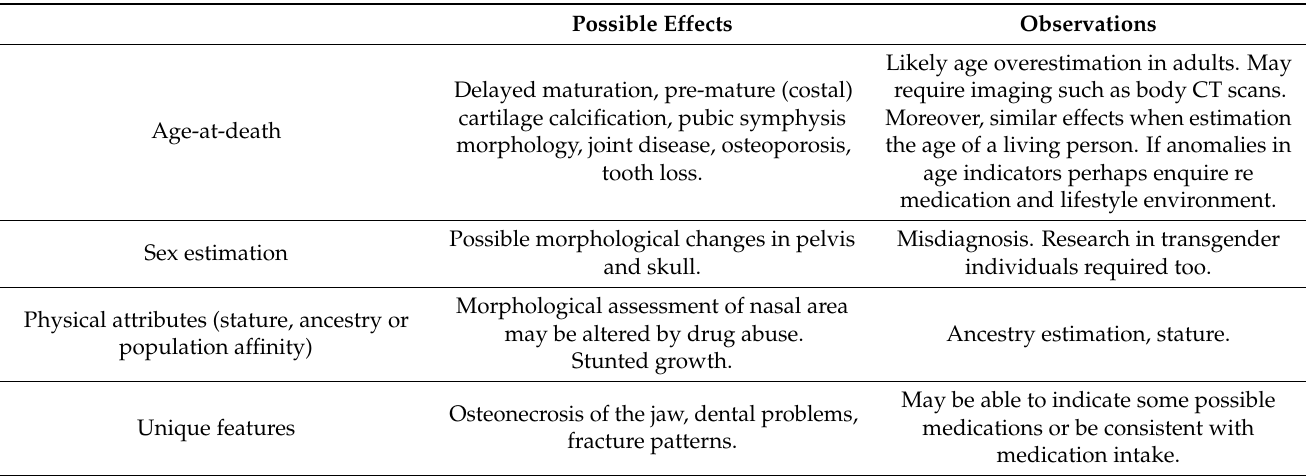
Table 4. Awareness of how drugs could affect biological profile reconstruction in forensic